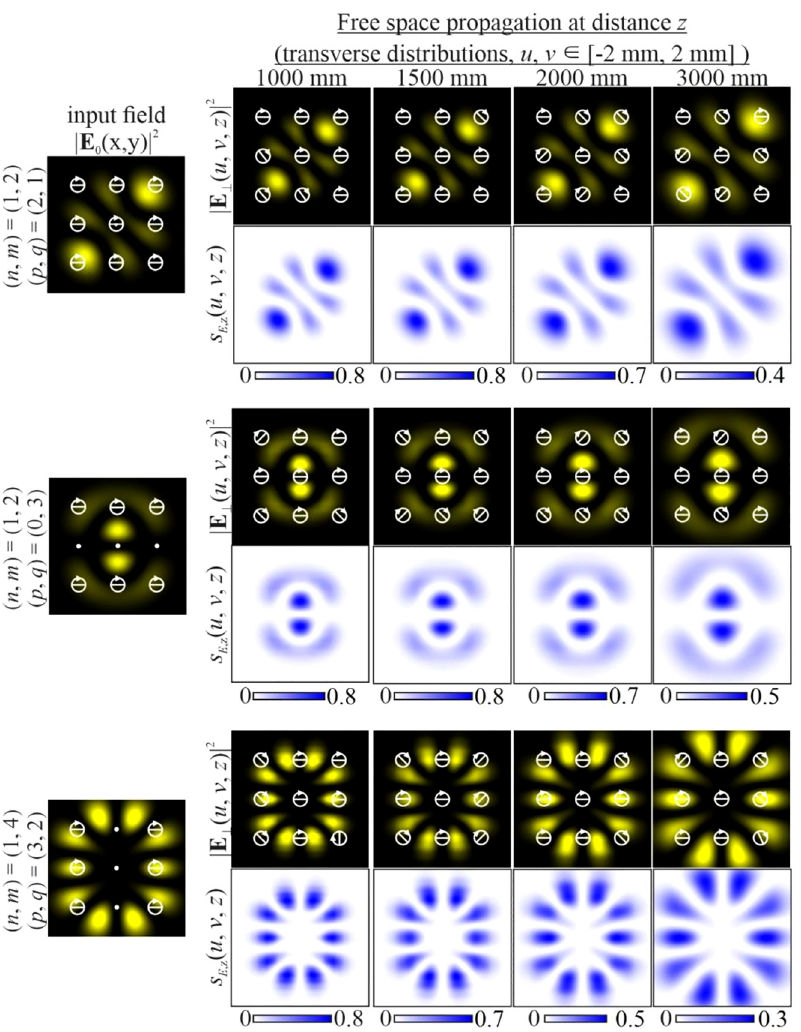
Figure 3: Propagation of uniformly polarized ( “ + ” -circular polarization) two-mode HG beams de fi ned by Eq. (26) with indices ( n + m ) = ( p + q ) (uniformly polarized vector